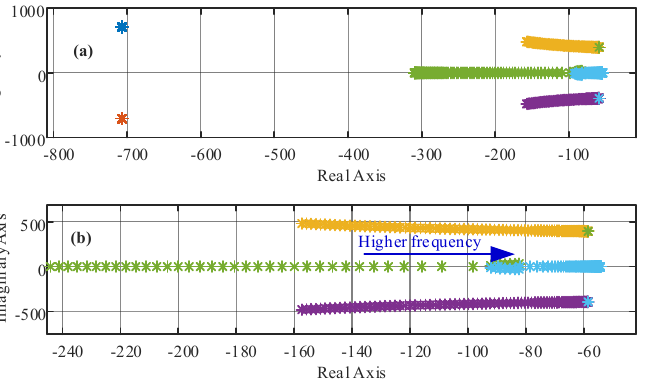
Figure 6. A NL eigenvalues as a function of the ac main frequency (from 30 to 100 Hz), ( a ) all six values, ( b ) zoom to the unstable eigenvalues.